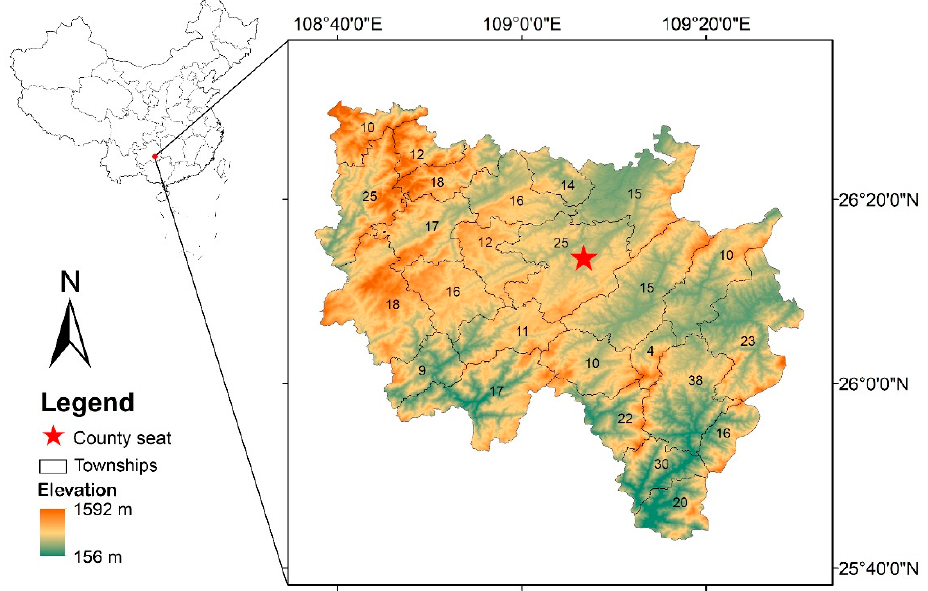
Figure 1. Location of the Liping County. Numbers indicate the number of villages and/or towns in each township (390 villages and 33 towns, in total). Elevation data from [36].